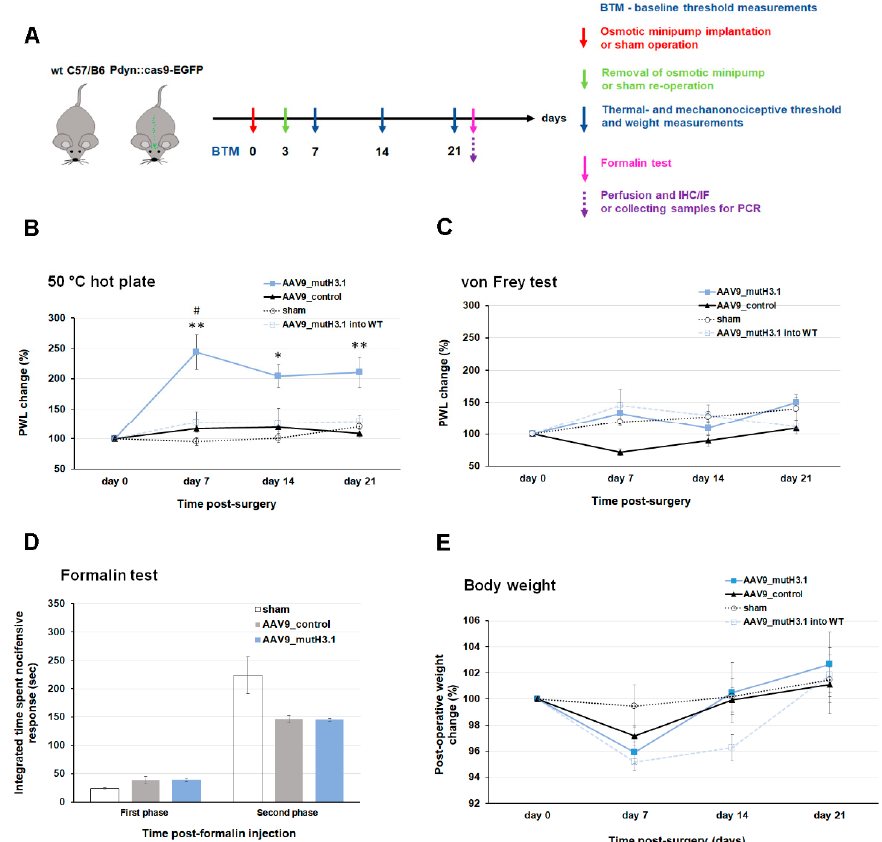
Figure 4. Intrathecal administration of AAV9_mutH3.1 into Pdyn::cas9-EGFP mice increases the thermal nociceptive threshold. ( A ) Schematic time scale of the experimental procedures. WT, wild- type C57Bl/6; IHC, immunohistochemistry; IF, immunofluorescent staining. ( B , C ) Changes in paw withdrawal latencies (PWL) to thermal- and mechanical pain were evaluated before (day 0) and after the surgery (day 7, 14, 21) in different groups of Pdyn::cas9-EGFP mice (i.e., AAV9_mutH3.1, AAV9_control, sham-operated) and in wild-type animals transduced with the AAV9_mutH3.1. Val- ues at Day 0 represent the pre-surgery baseline values (BTM). ( B ) AAV9_mutH3.1-treated animals exhibited higher thermal nociceptive threshold compared to the AAV9_control and sham operated groups at day 7. This significant elevation was persistent until the end of the observational period. * p < 0.05 and ** p < 0.01 compared with the AAV9_control group (details in Supplementary Table S4). # p < 0.01 when the overall influence of the treatment with the AAV9_mutH3.1 on paw with- drawal latency (PWL) in response to noxious heat compared with the pre-surgery baseline ( p = 0.009, n = 7, Kruskal–Wallis ANOVA). ( C ) Paw withdrawal latency to painful mechanical stimuli showed no significant alterations within, and differences between the groups. ( D ) Formalin-induced somatic pain was quantified as the integrated time spent exhibiting nocifensive behavioral during early (0– 15 min) and late (15–60 min) phases of formalin application. Formalin-induced nocifensive behavior was reduced by 40% in the second phase in mice that had been infected with AAV9 irrespectively from their transgenes to be expressed, although, this reduction did not reach a statistically signifi- cant level. For additional details for statistical comparison see Supplementary Table S4. See also Supplementary Figure S5 for raw data of the formalin-induced nocifensive behavior. ( E ) Changes in body weight were evaluated before (day 0) and after the surgery (day 7, 14, 21) in different groups of Pdyn::cas9-EGFP mice (i.e., AAV9_mutH3.1, AAV9_control, sham-operated). Day 0 represents the pre-surgery baseline value. Transduction with the viruses (AAV9_mutH3.1 or AAV9_control) led to a modest body weight loss by day 7 that resolved later in all groups.